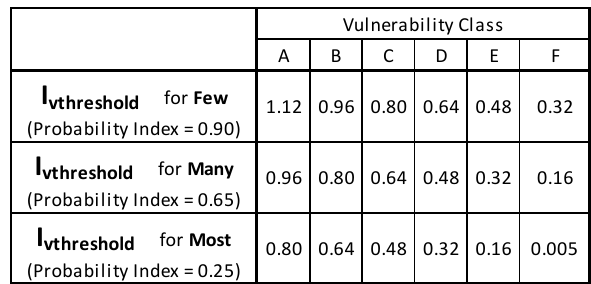
Table 5. Threshold indices for few, many, most quantities.